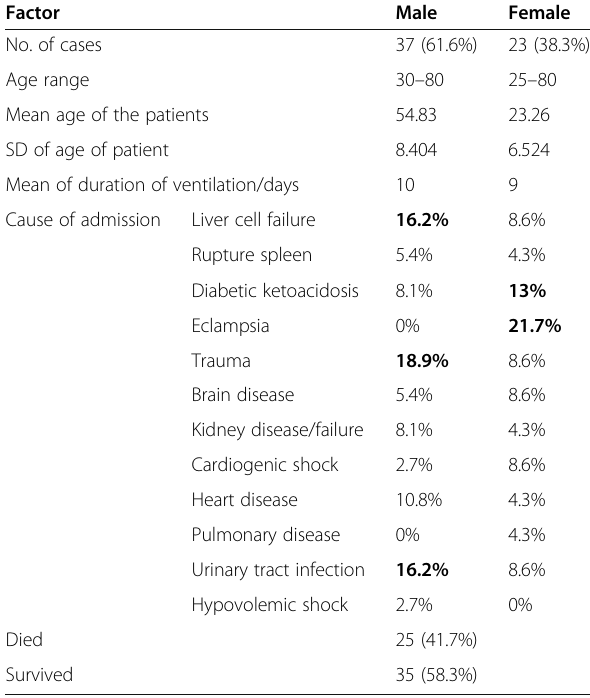
Table 2 Gender distribution among BSU Hospital VAP